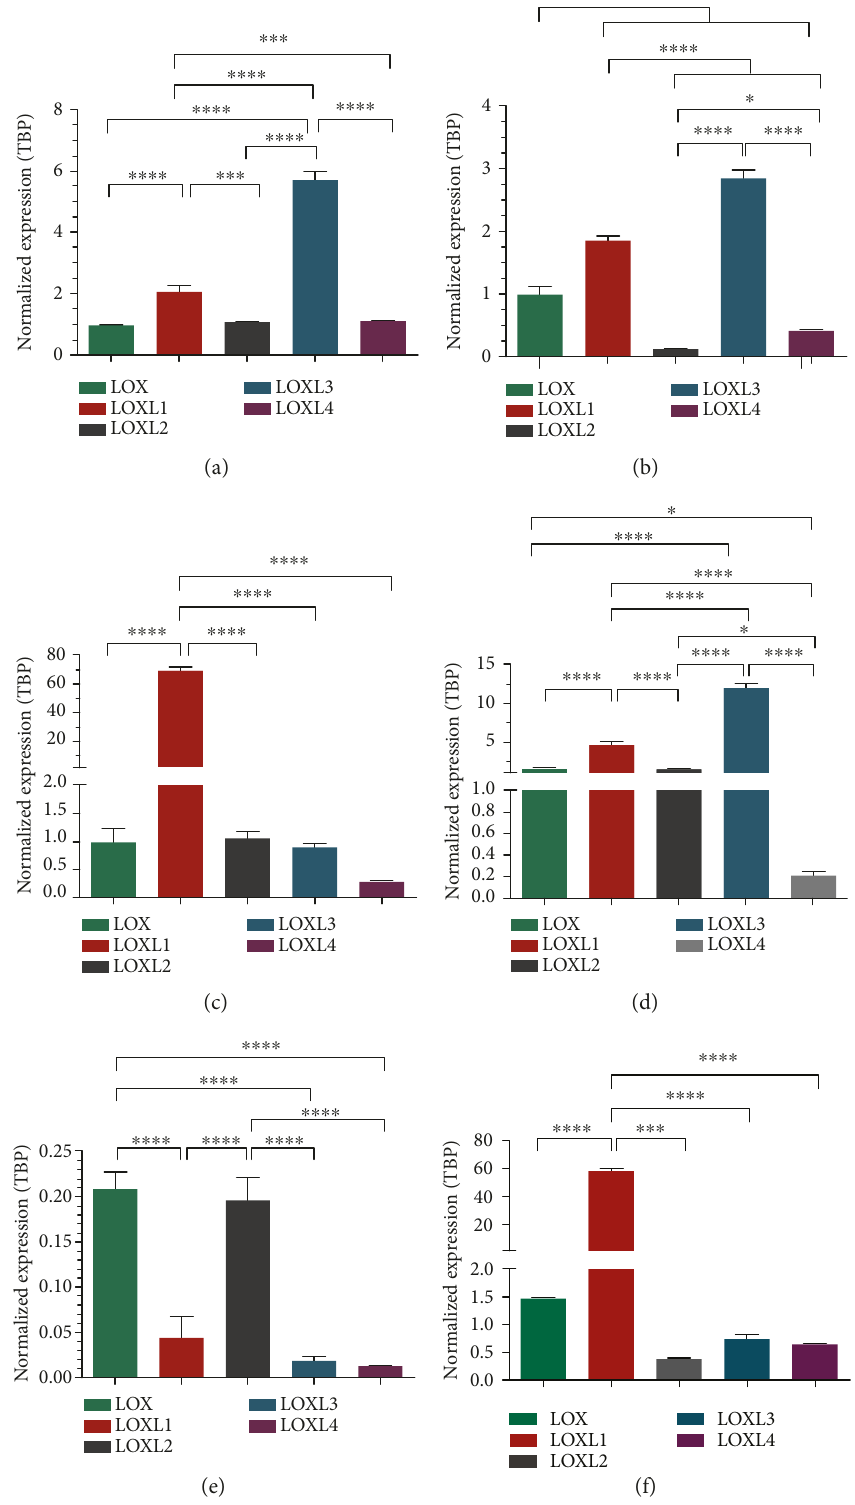
Figure 3: Comparative analysis of LOX and LOXL1 – 4 expression pro fi les in normal and tumor-associated pericytes. Gene expression was assessed by quantitative real-time PCR, using TBP as endogenous control. Normal pericyte samples: NP-Ad and NP-Mu. Tumor- associated pericyte samples: TP-Nbl and TP-Epn. Endothelial cells (HUVEC) and mesenchymal stem cells (MSCs) were also included in the analysis as control samples. (a) NP-Ad; (b) NP-Mu; (c) TP-Nbl; (d) TP-Epn; (e) HUVEC; (f) MSC. Signi fi cance level: ∗ P < 0 05 , ∗∗ P < 0 01 , ∗∗∗ P < 0 001 , and ∗∗∗∗ P < 0 0001